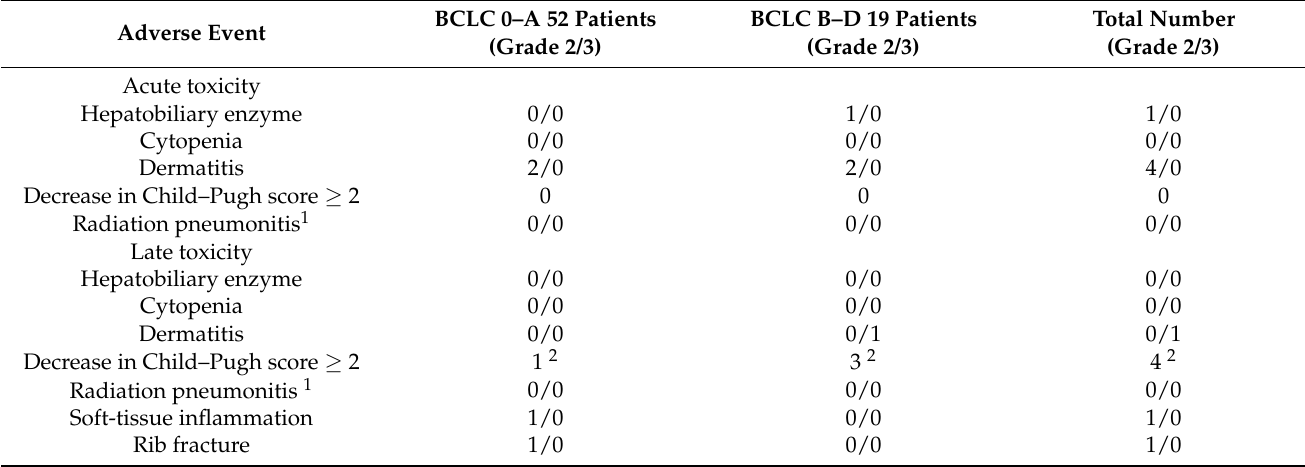
Table 5. Acute and late complications related to image-guided proton therapy.